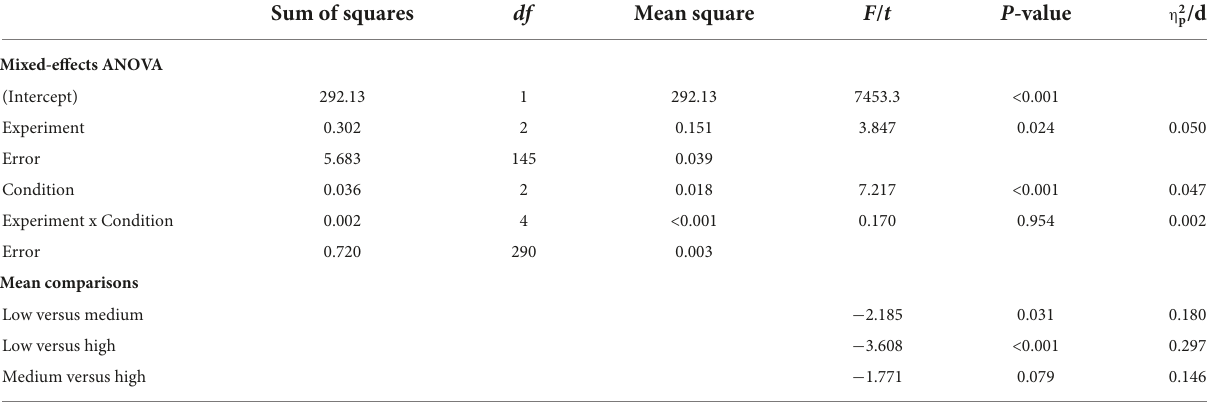
TABLE 3 Repeated measures ANOVAs for the model-fitted average hit rate as a function of Condition (low, medium, and high reward probability). Sum of squares df Mean square F / t P -value η 2